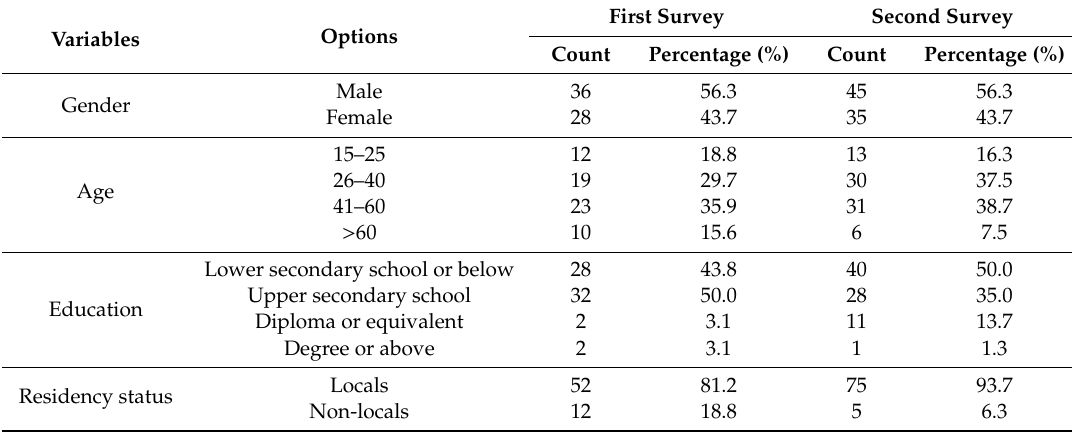
Table 4. Respondents’ demographic